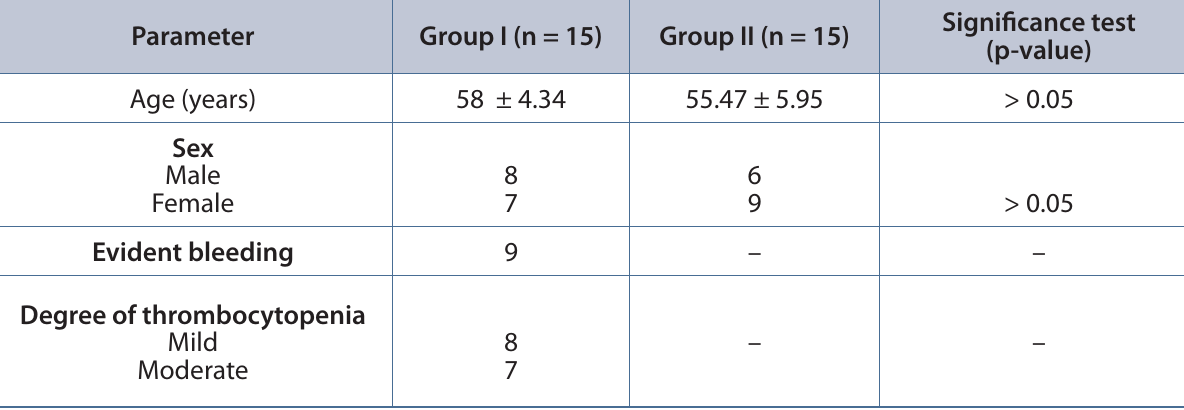
Table 1. Clinical data of the studied groups